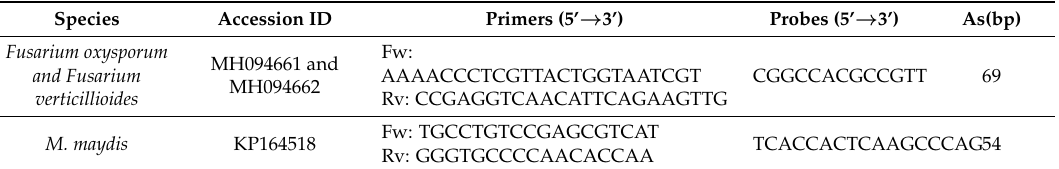
Table 1. qPCR oligonucleotide primers and probes designed on internal transcribed spacer (ITS) gene region. AS: amplicon